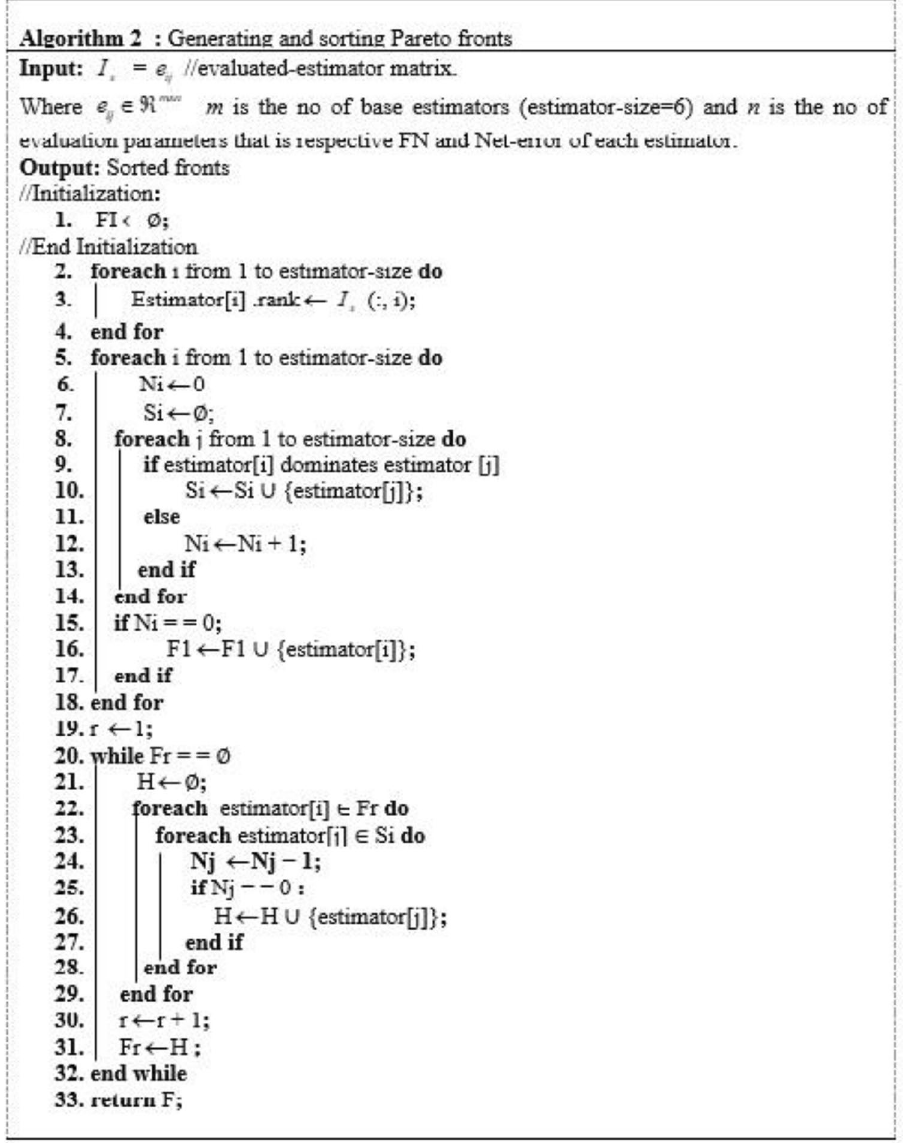
Figure 6. Algorithm 2: generating and sorting